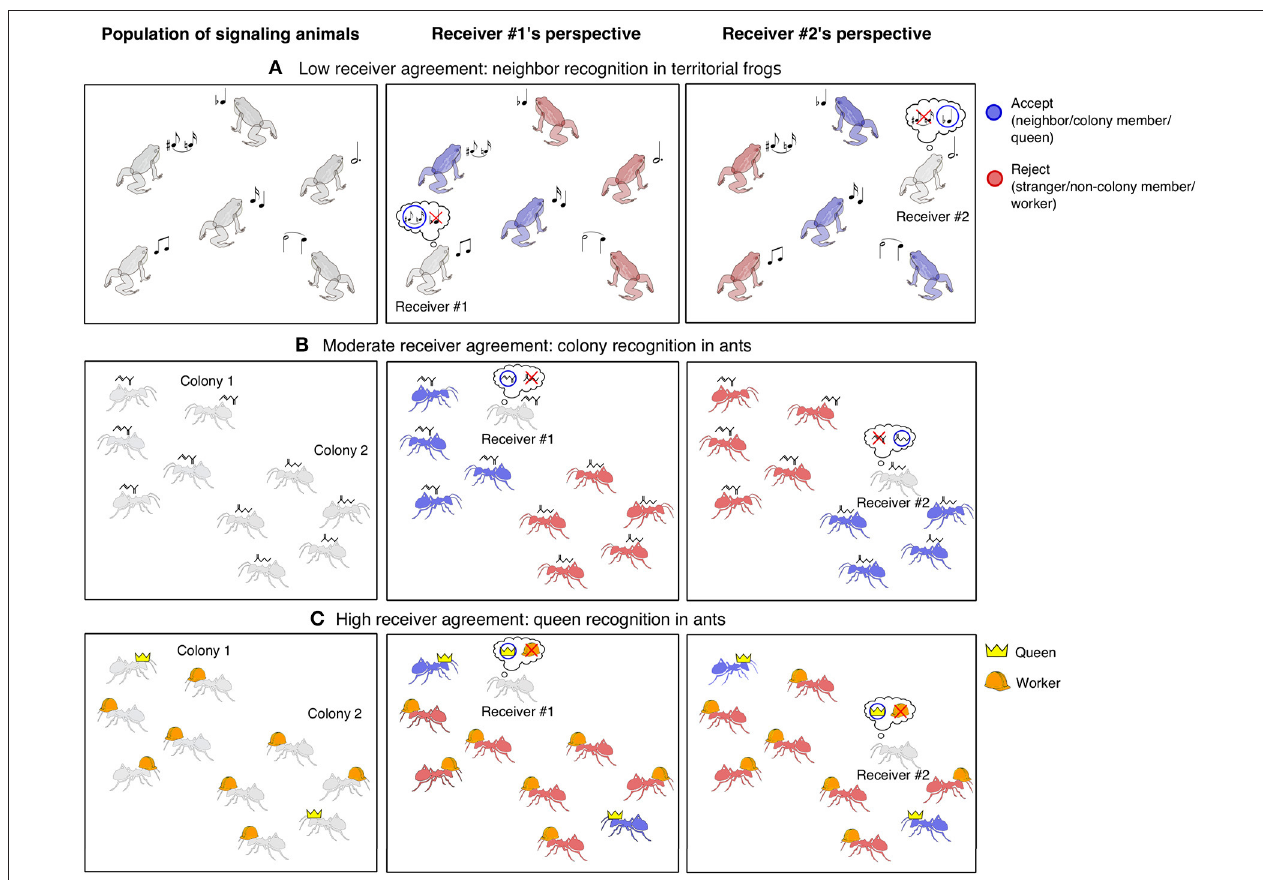
FIGURE 1 | Among recognition systems, receivers vary in the extent to which they agree on the category membership of senders. (A) In a population of territorial frogs, individuals are categorized as either neighbors, or strangers depending on their spatial proximity to a particular receiver. Receivers thus have low agreement on category membership and individuals must have individually distinctive traits (e.g., calls represented by musical notes in this example) to be recognized as members of such egocentric categories. Note: for simplicity, only two calls are shown in the receiver thought bubbles. (B) All members of a colony of ants share the same cuticular hydrocarbon profile, which differs between colonies. The decision of whether to accept an individual as a colony member or reject it as a non-colony member depends on the colony to which a receiver belongs. At the level of the population, there are moderate levels of receiver agreement because all members of the same colony agree on who belongs in which categories, but members of different colonies disagree. (C) Whether an individual is a queen (represented by a crown) or a worker (hard hat) is an objective social category that does not depend on the perspective of a receiver, resulting in high agreement about category membership among a population of